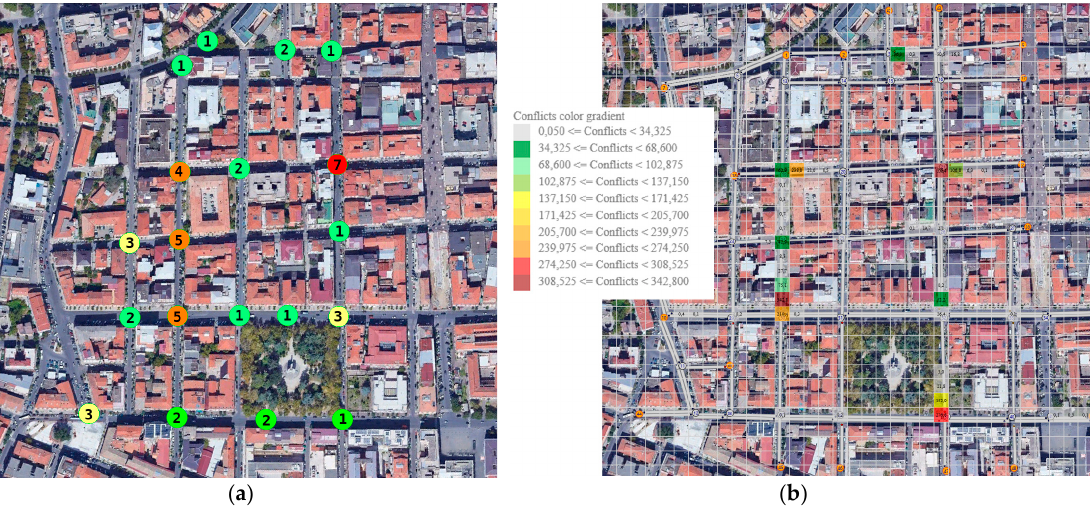
Figure 6. ( a ) Accidents locations from CRISC dataset; ( b ) Potential conflicts risk areas from simulation.